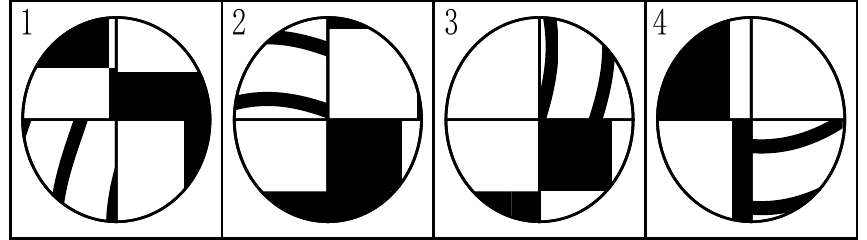
Figure 7. Switching sequences for CT6 configuration.